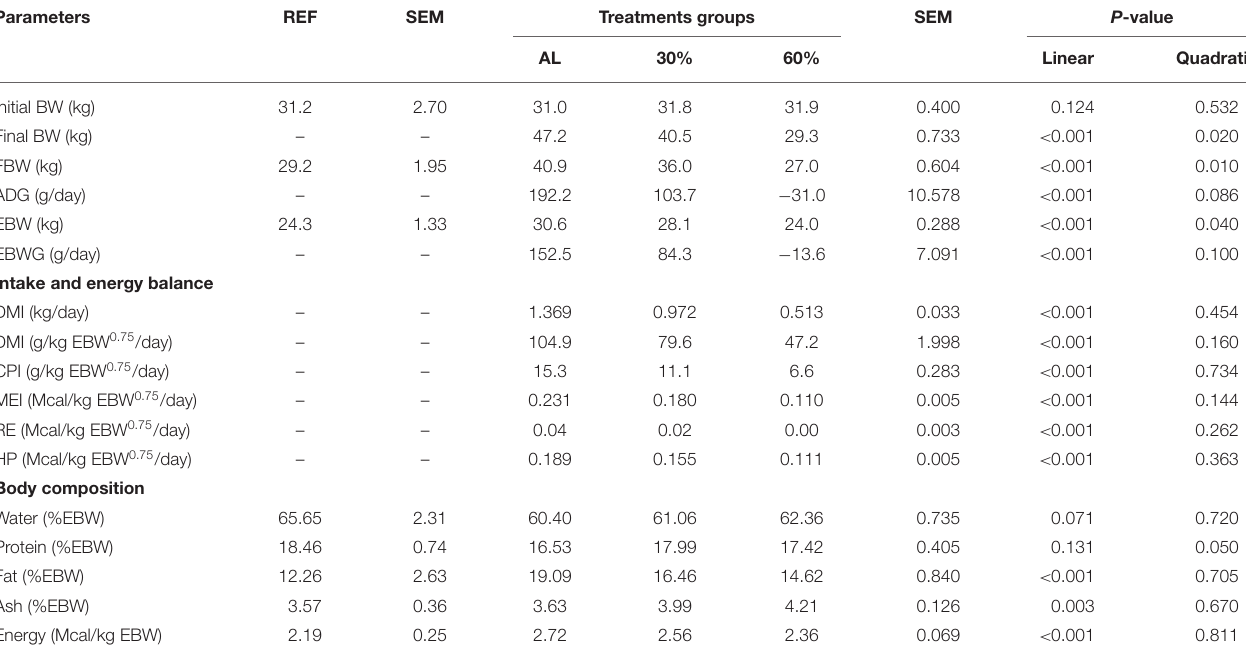
TABLE 2 | Effects of feed restriction on performance, intake and energy retention, and body composition in intact males Dorper × Santa Ines lambs.